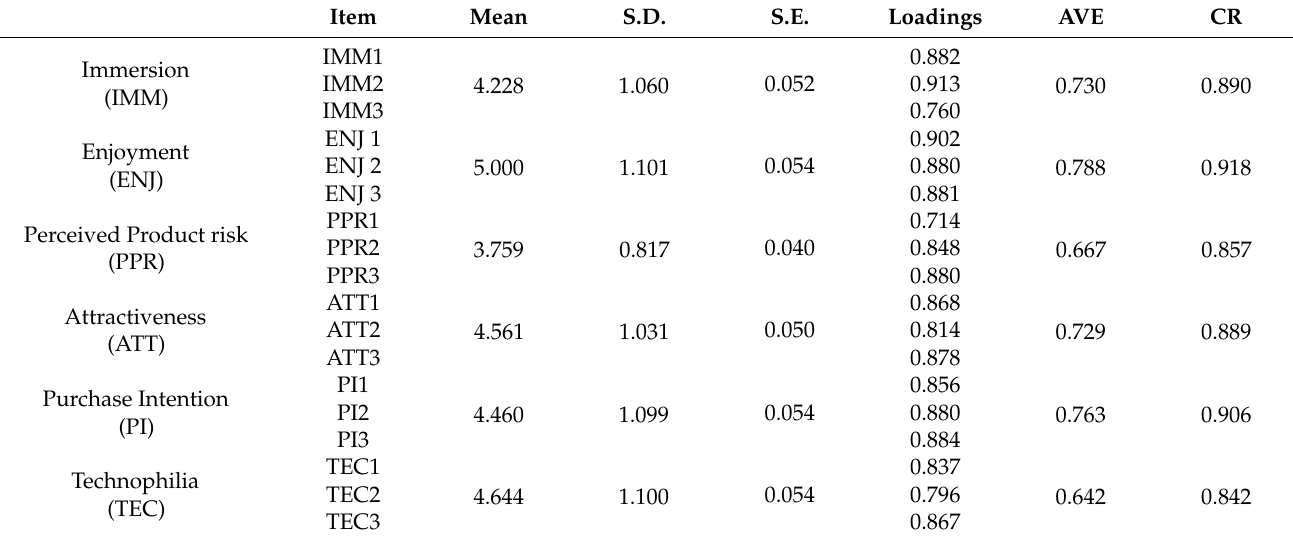
Table 1. Assessment of reliability and convergent validity.